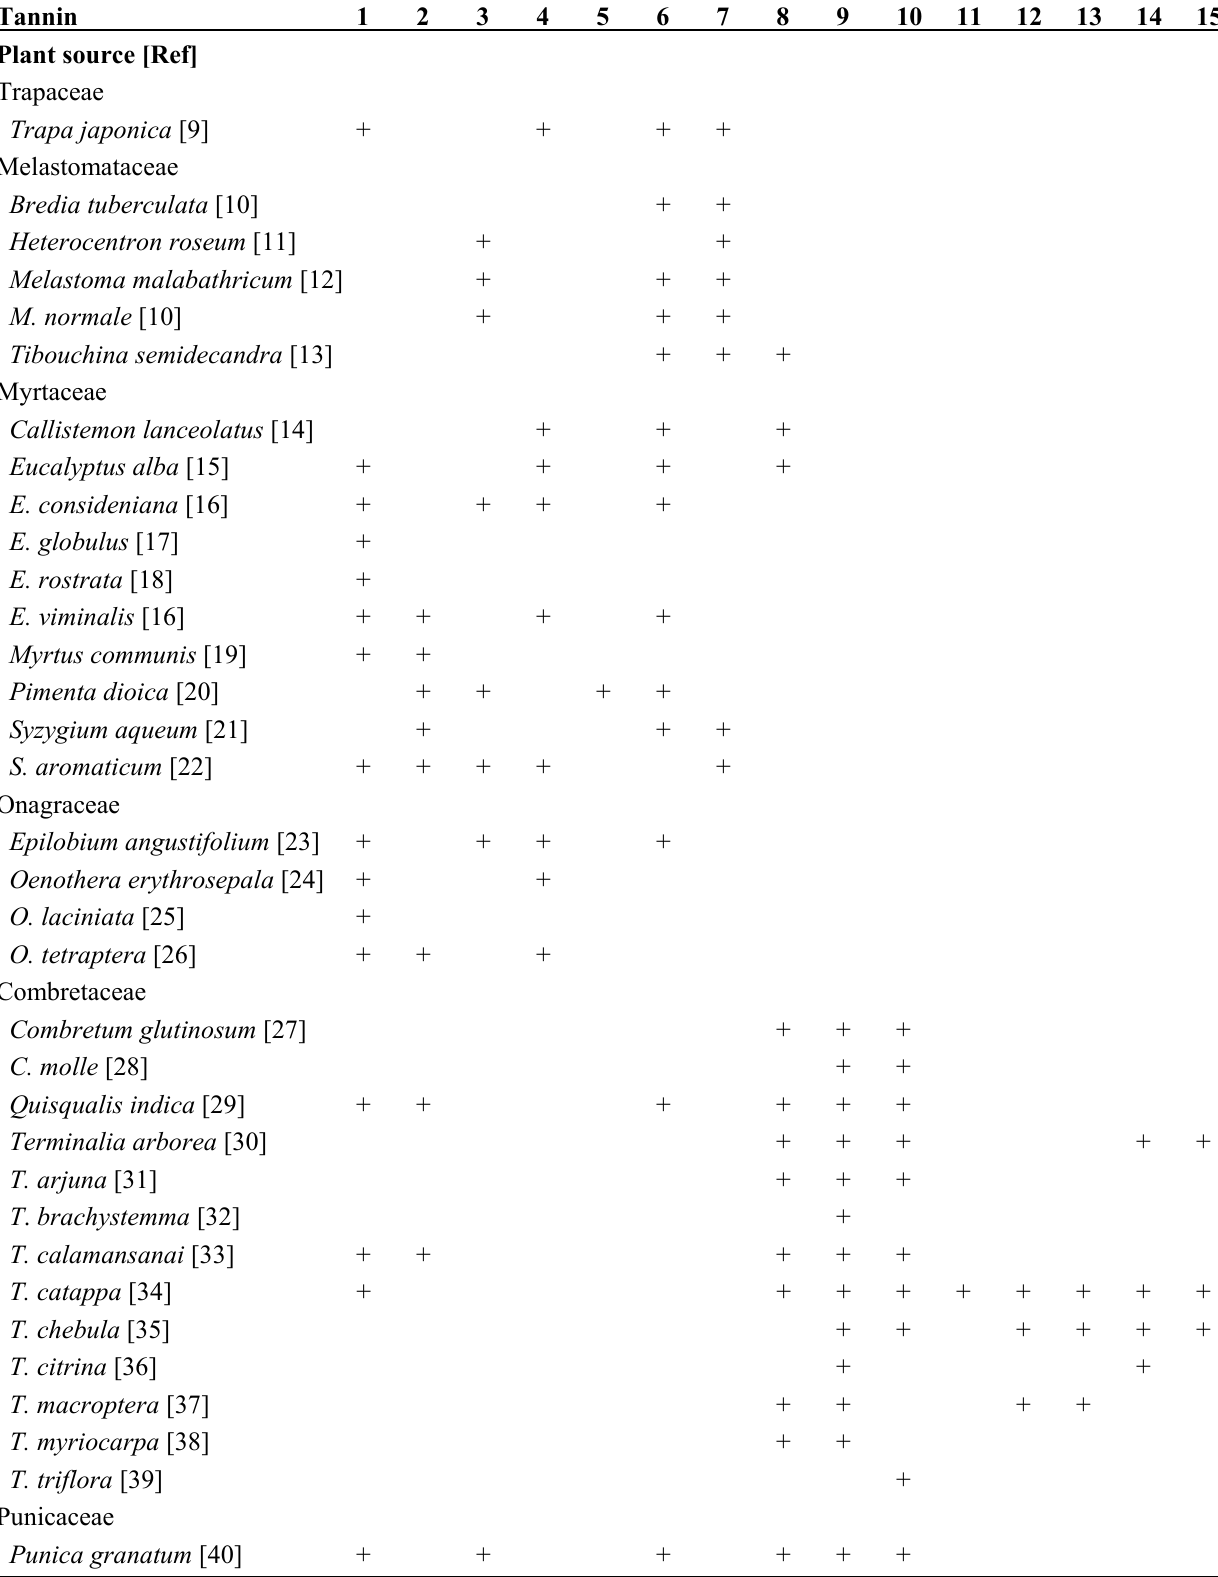
Table 1. Ellagitannin monomers found in the